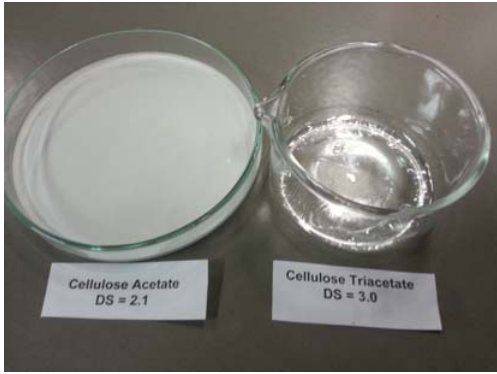
Figure 4. Evaporation of dichloromethane F and G solutions. The F transparent